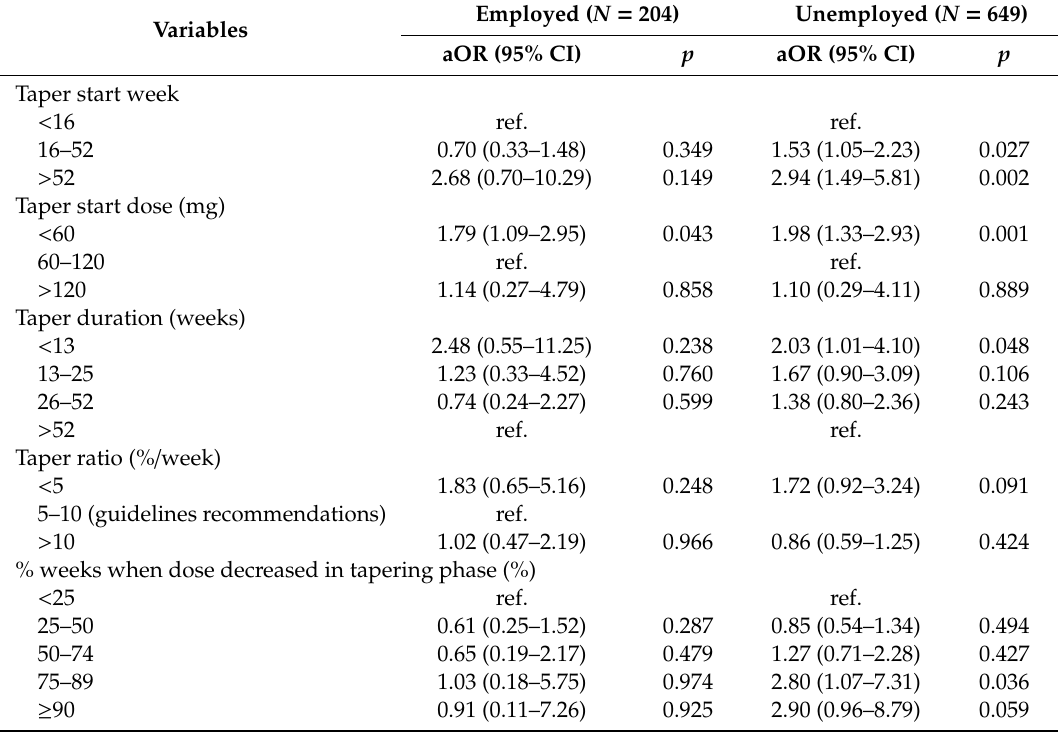
Table 4. Subgroup analyzes of the e ff ect of variables on heroin abstinence in di ff erent employment